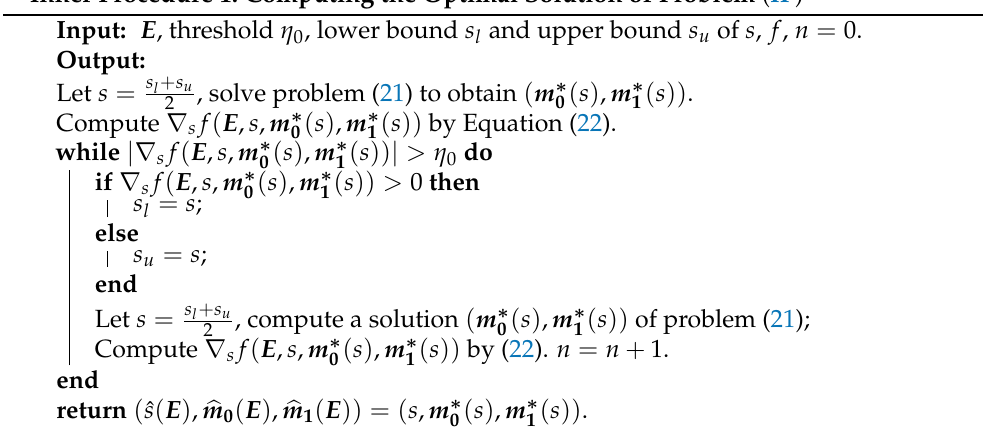
Inner Procedure 1: Computing the Optimal Solution of Problem ( IP